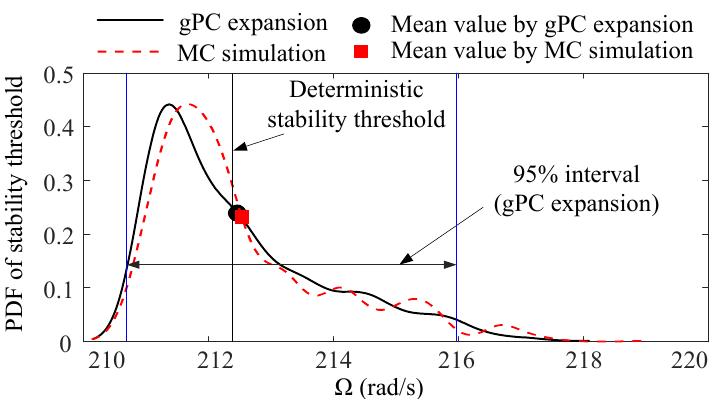
Figure 11. PDF of stability threshold by gPC expansion and MC